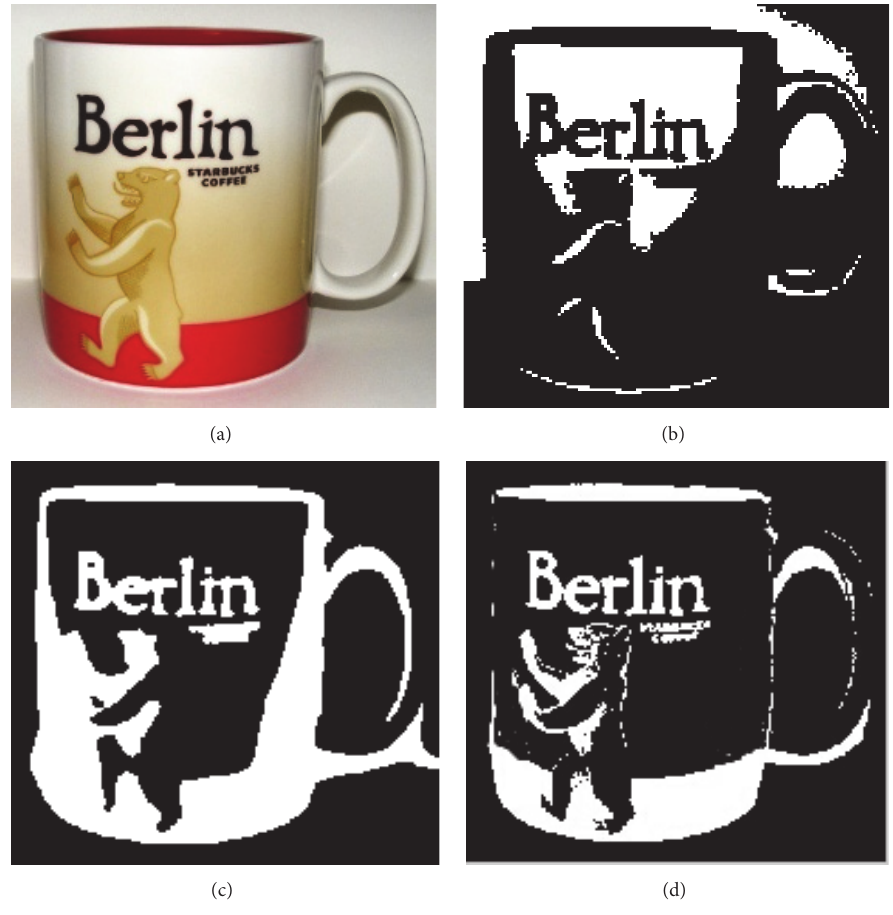
Figure 3: (a) Primary image. (b) CV segmentation. (c) BFV segmentation. (d) TLBO-BFV